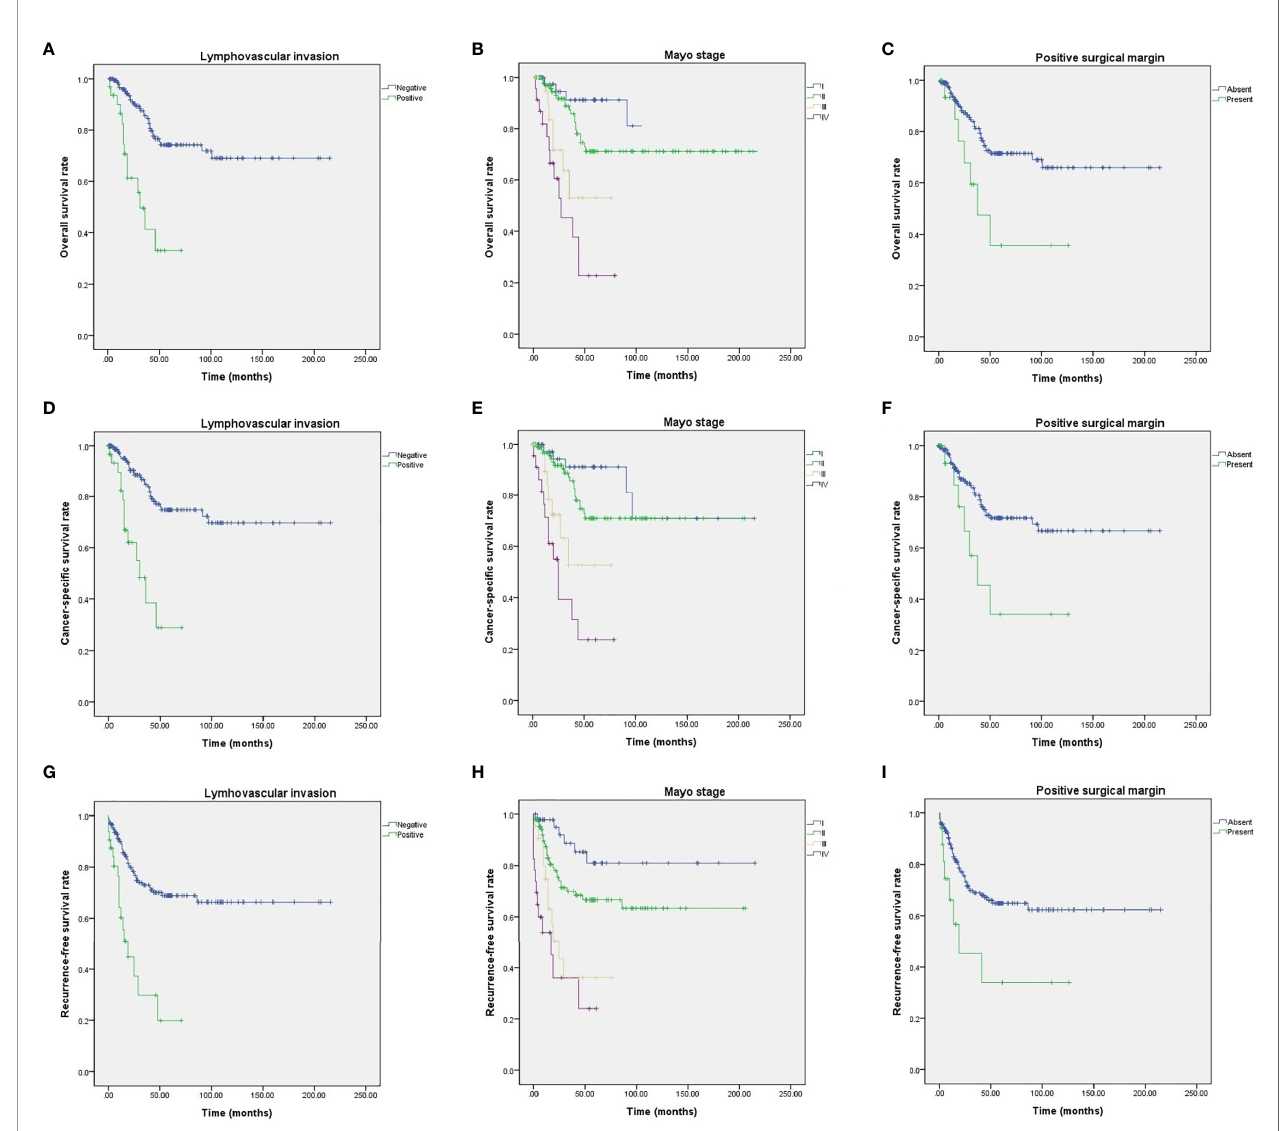
FIGURE 2 | Kaplan – Meier analyses of UC patients with different survival outcome predictors. (A) OS for PLM. (B) OS for Mayo stages. (C) OS for PSM. (D) CSS for PLM. (E) CSS for Mayo stages. (F) CSS for PSM. (G) RFS for PLM. (H) RFS for Mayo stages. (I) RFS for